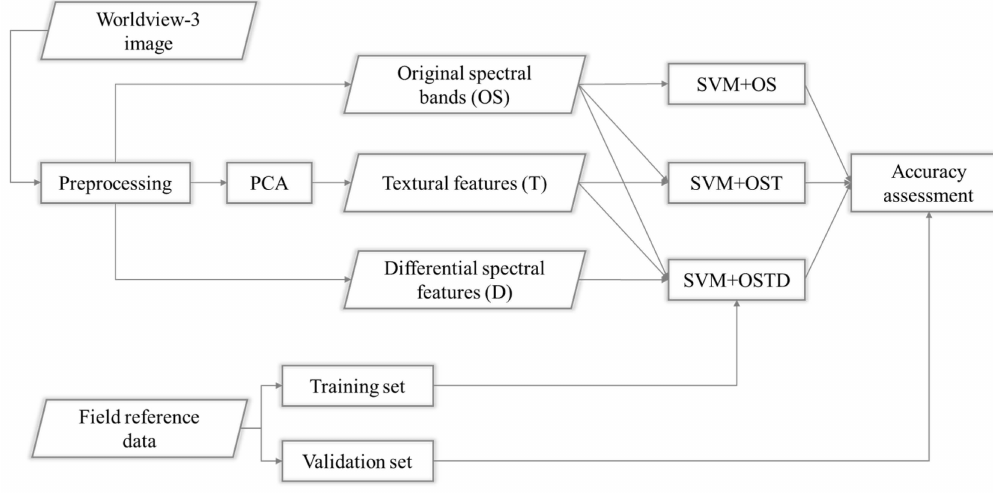
Figure 4. Flowchart of the method